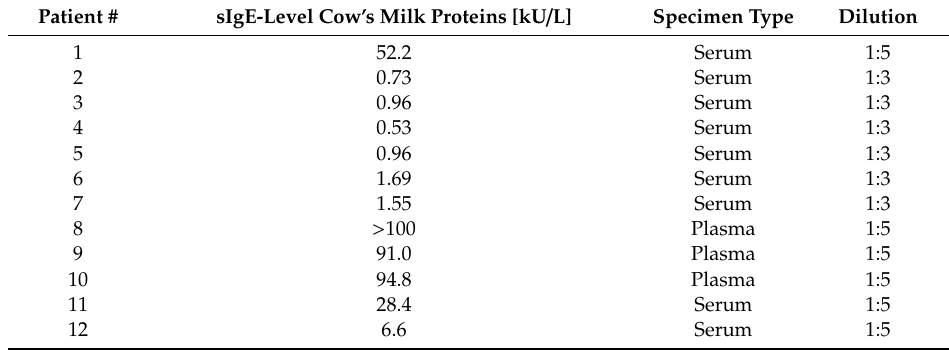
Table 1. sIgE levels of sera from cow’s milk allergic patients. sIgE levels as measured by ImmunoCap. sIgE-Level Cow’s Milk Proteins [kU / L]